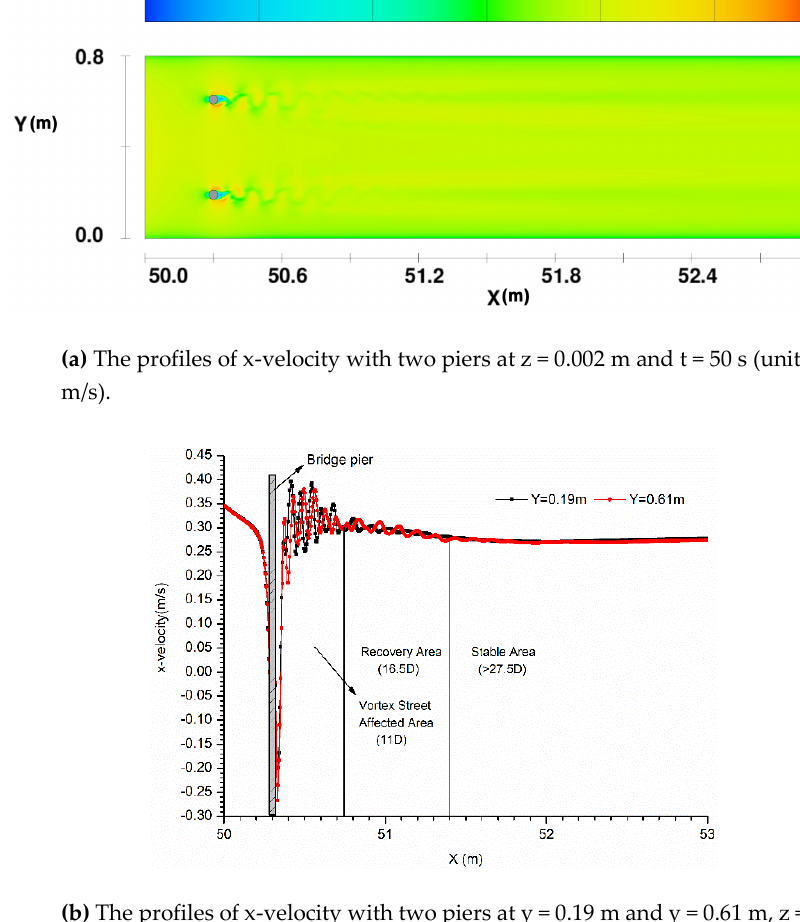
Figure 6. The profiles of x-velocity with two piers. 194